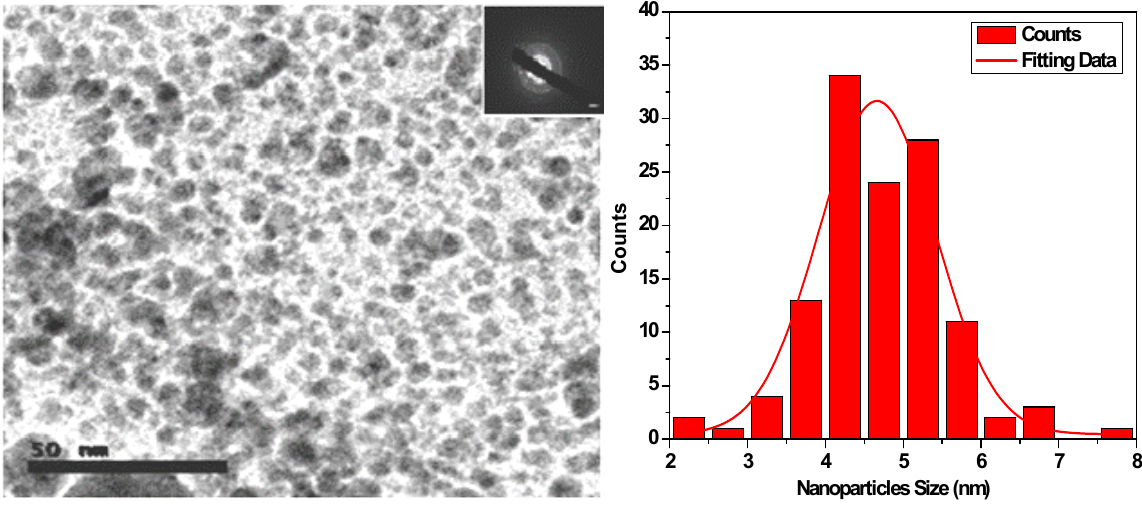
Figure 1. HRTEM image and size dispersion histogram of Ag nanoparticles.